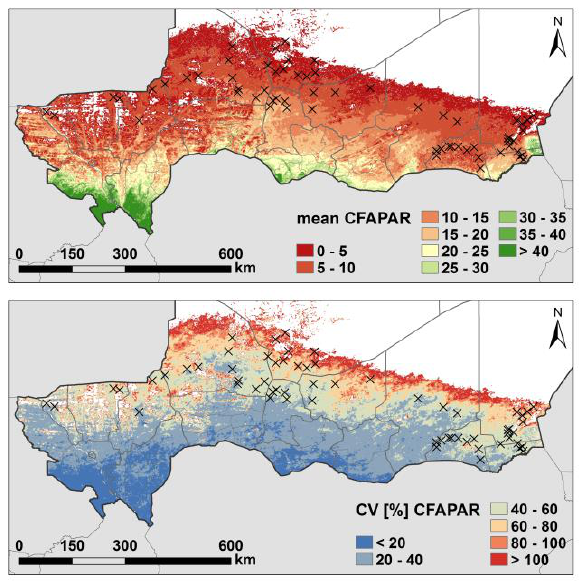
Figure 4. Mean CFAPAR (top) and CV of CFAPAR (bottom) for the period 1998–2012. White areas reflect non-vegetated areas (for a definition see